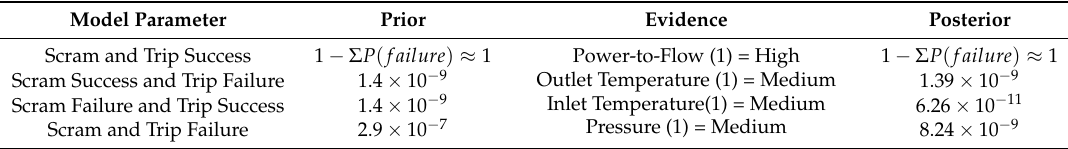
Table 3. Prior and posterior probabilities of scram, prognostics, and system diagnostics with evidence of high power-to-flow ratio.